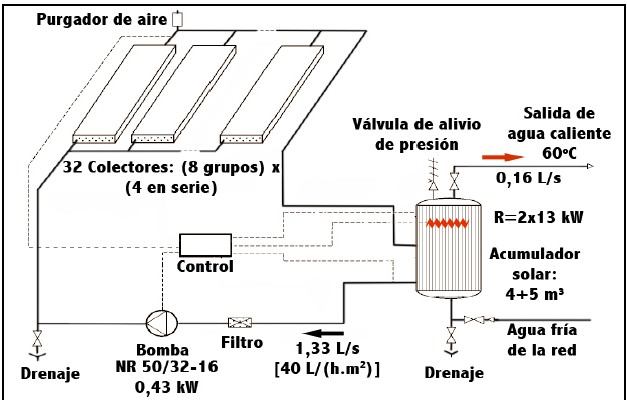
Figura 1: Esquema principal del caso propuesto.